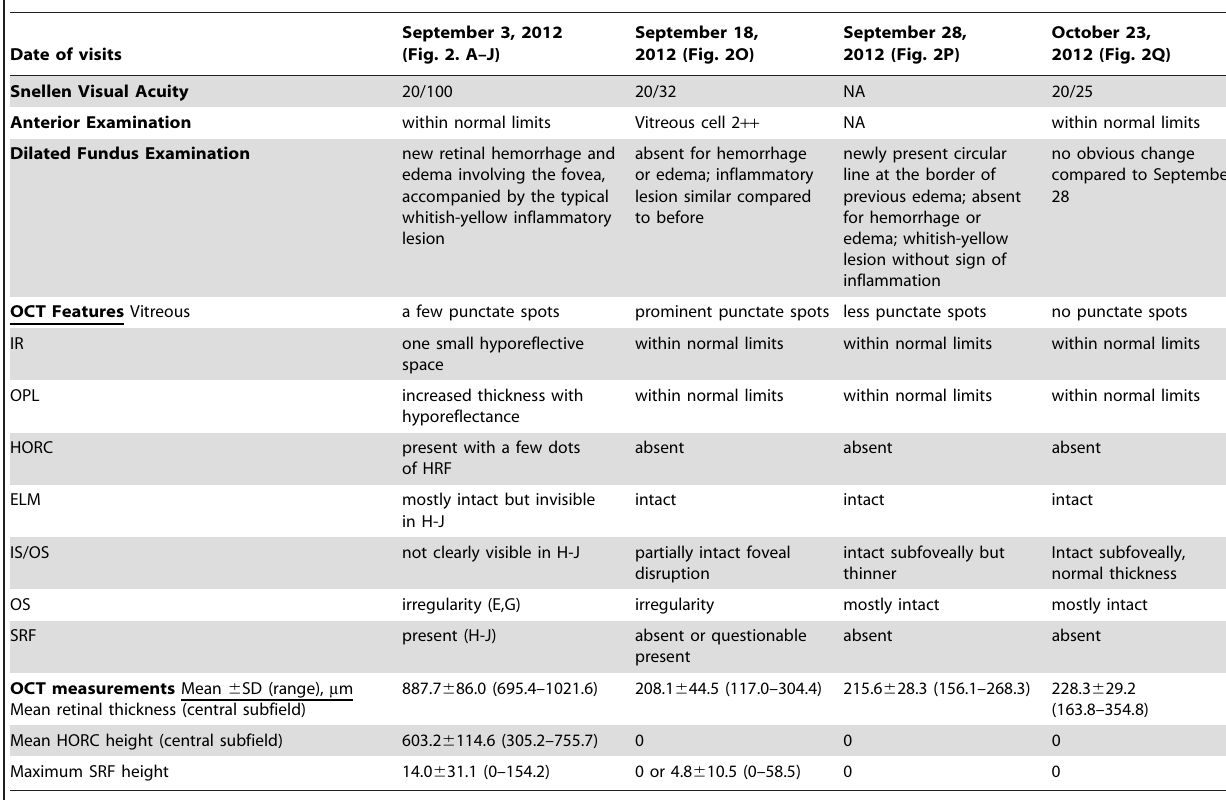
Table 1. Clinical Examinations for Case